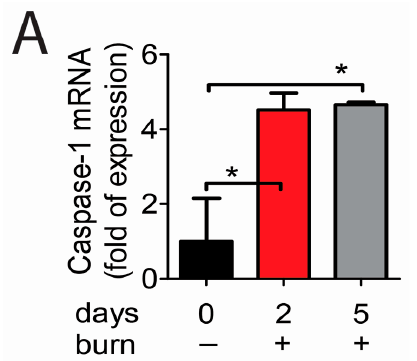
Figure 3. Cont. Figure 3.